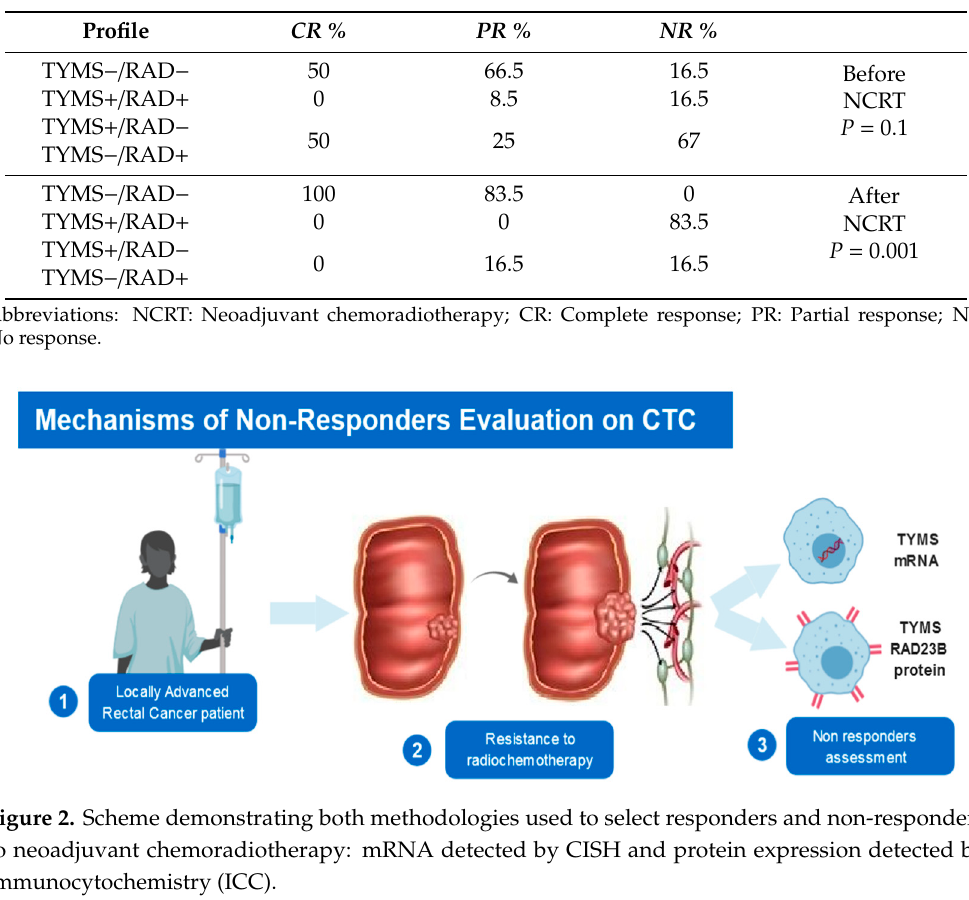
Table 4. Correlation between RAD and TYMS protein expression profiles.